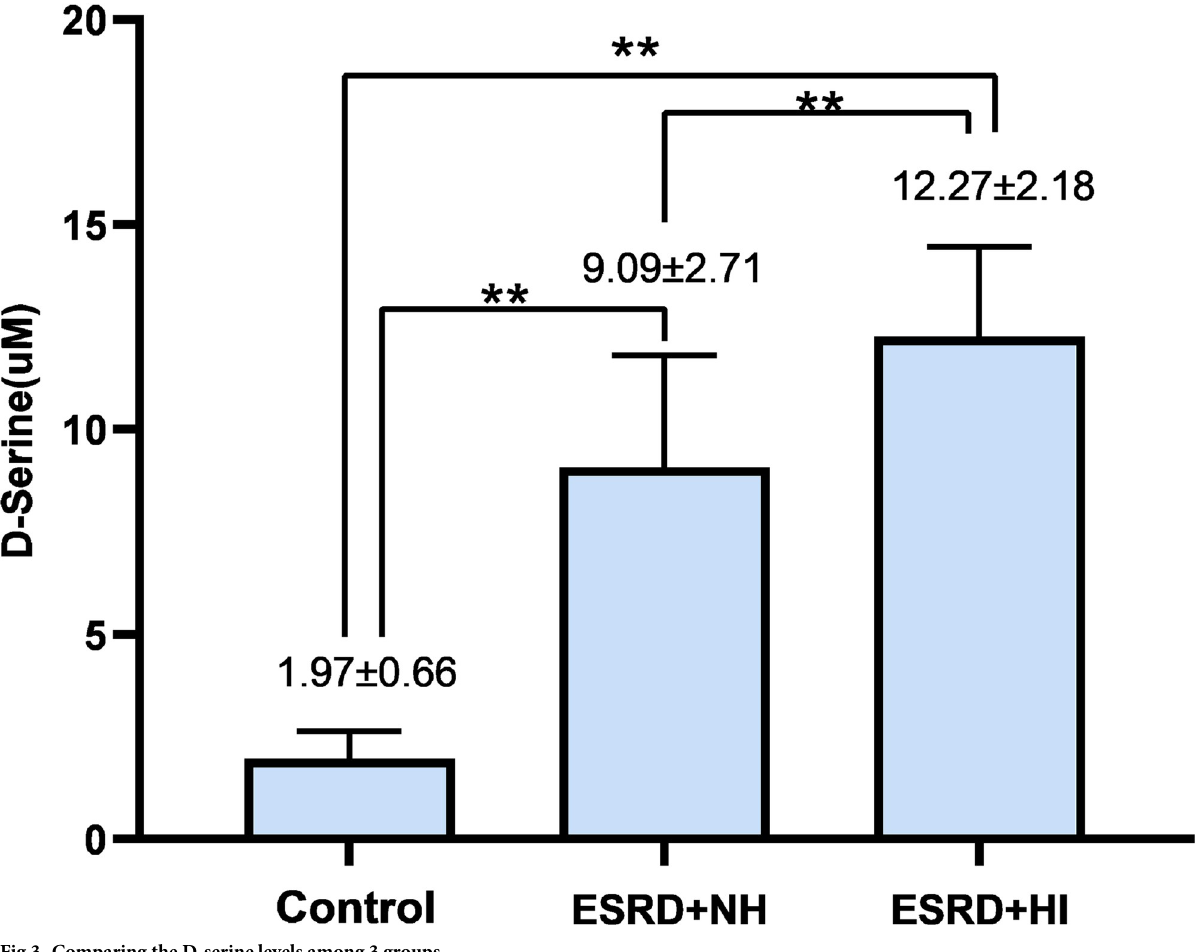
Fig 3. Comparing the D-serine levels among 3 groups.